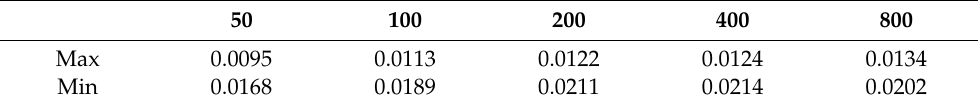
Table 11. Procrustes distances between the predicted landmark and semilandmark configurations from sliding TPS and TPS&NICP corresponding to the maximum (Max) and minimum (Min) cen- troid